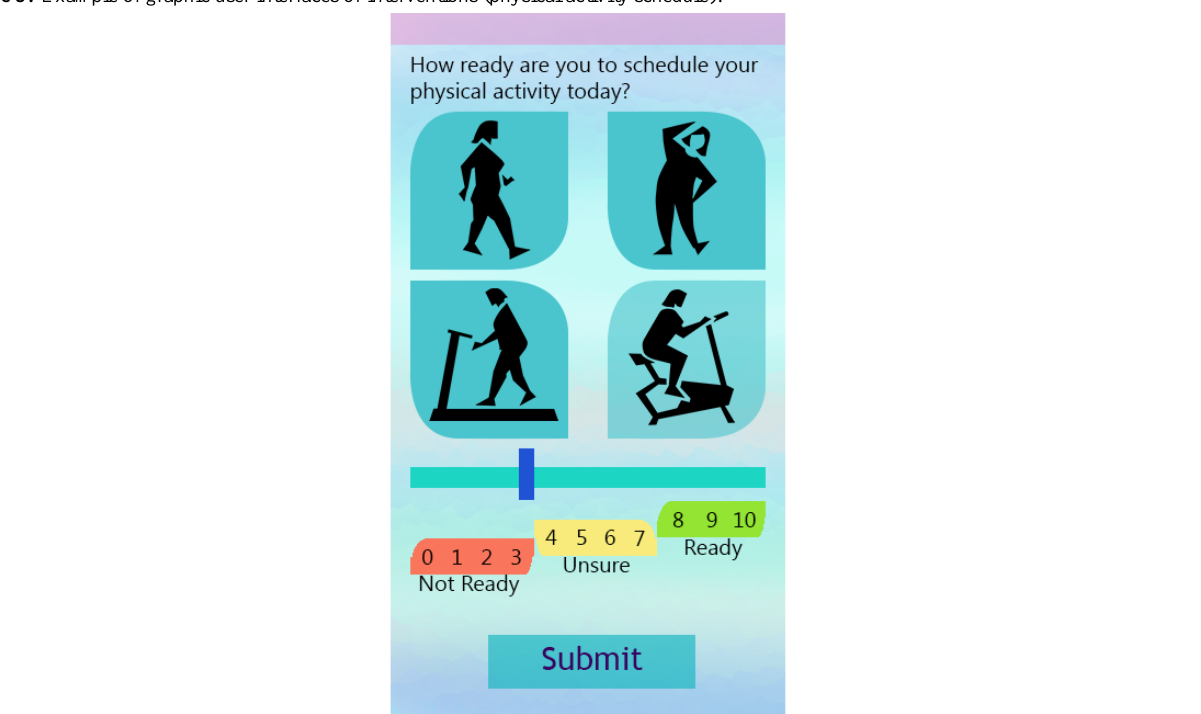
Figure 3. Example of graphic user interfaces of interventions (physical activity